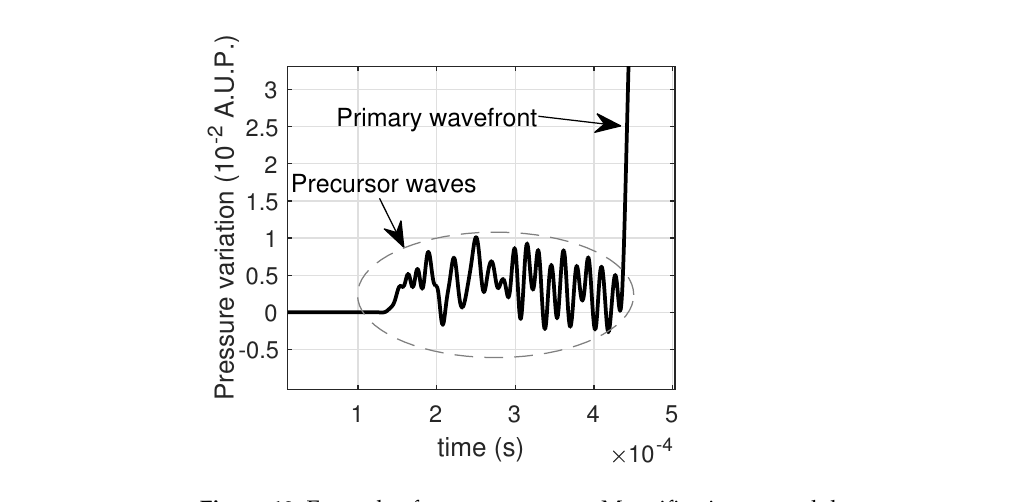
Figure 10. Example of precursor waves: Magnification around the precursor waves on the pressure history at point C5 (535.8 × 10 − 3 A.U.L. from the failure). To confirm that interpretation, we estimate the velocities of the observed low-amplitude waves and main wavefront to compare them with the theoretical values of precursor and primary waves. Velocities are estimated by the time difference of arrival (TDOA) between the different signals. TDOA is estimated for each couple of signals (such as the example in Figure 11); then, the average value is computed. We obtain the following average values (with a 95% confidence interval):